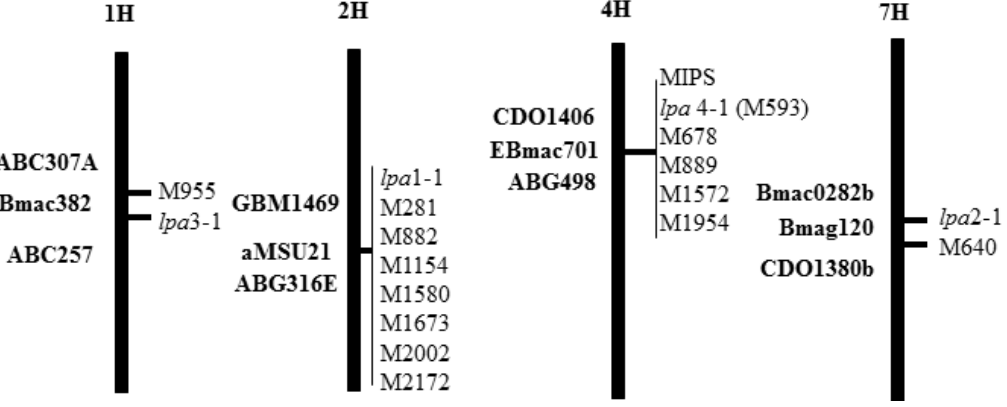
Figure 1. Chromosomal position of 17 barley low phytic acid mutations and the barley genome’s single myo -Inositol-3-P 1 synthase (MIPS) gene. Map positions are approximate and only meant to be illustrative of linkage groups. As indicated, all mutations fell into four linkage groups, but allelic or non-allelic relationships within each linkage group are not yet known. The molecular markers used in mapping are on the left of each chromosome. The lpa mutations comprising each linkage group are on the right of each